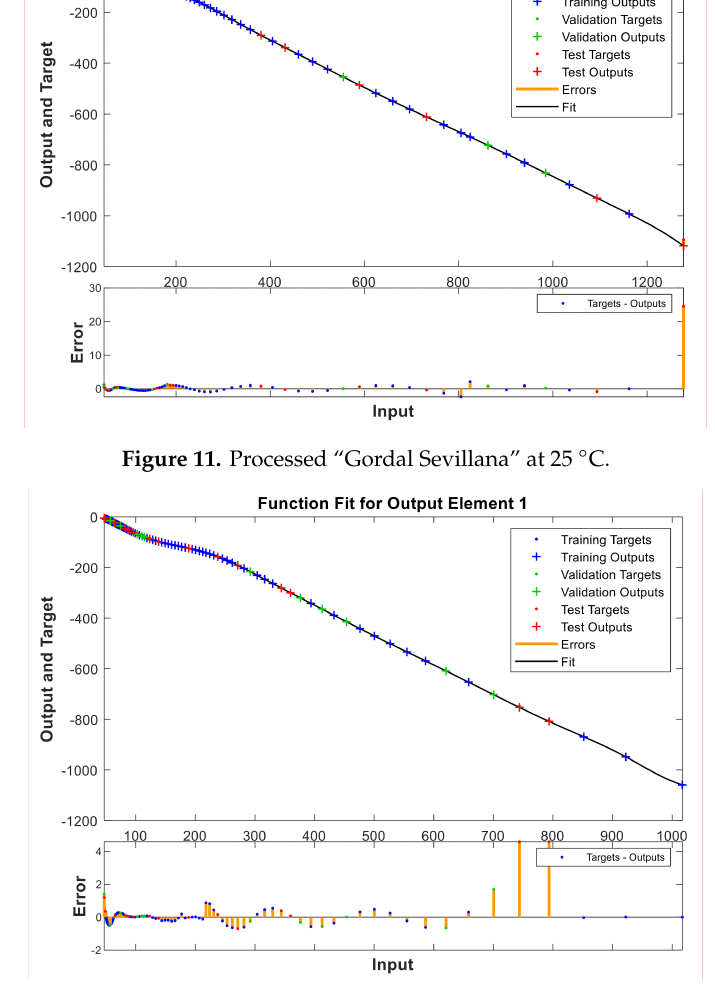
Figure 12. Processed “Hojiblanca” at 25 ◦ C.